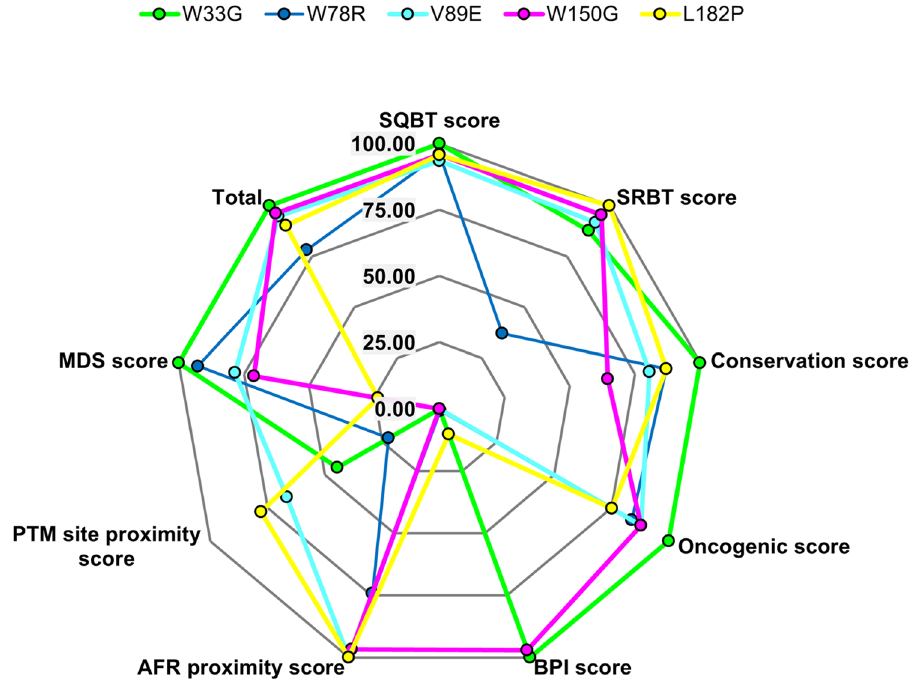
Figure 6. The relative deleterious nature of the five highly deleterious TPMT missense SNPs. A score of 100 for a mutation in a particular category indicates that the given mutation is the most deleterious with respect to that category (SQBT = Sequence-based tools, SRBT = Structure-based tools, BPI score = Binding pocket impact score, AFR = Amyloid forming region, PTM = Post-translational modification, MDS = Molecular dynamics